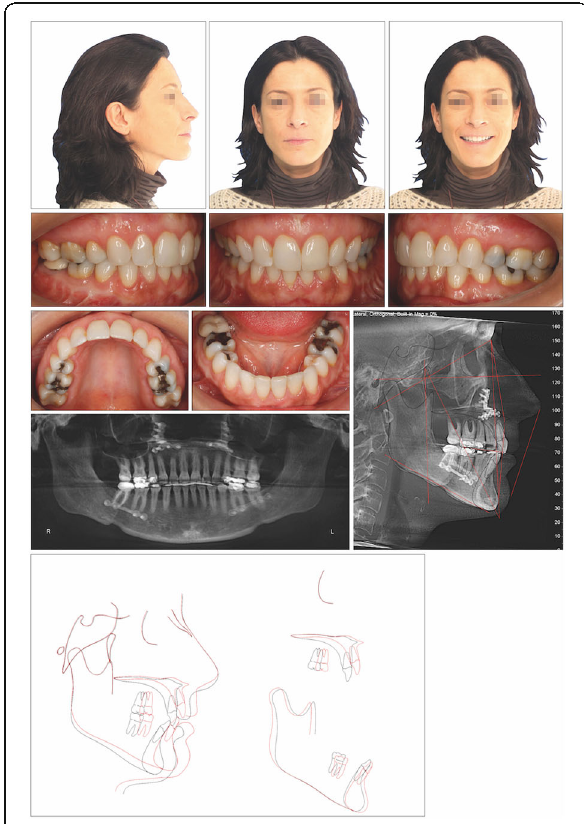
Fig. 6 Posttreatment records and superimposition of tracings before treatment ( black line ) and after treatment ( red line ) of patient